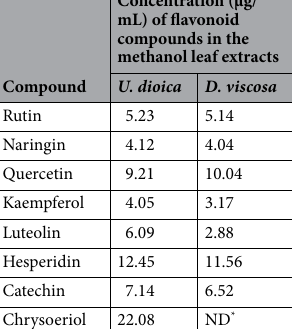
Concentration (µg/ mL) of flavonoid compounds in the methanol leaf Compound